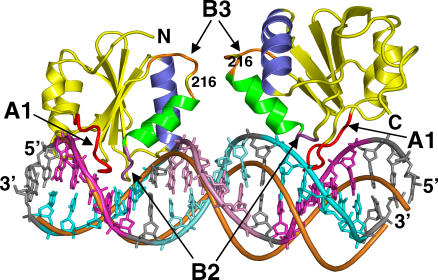
Overall Architecture of T-ag obds Bound to P1 and P3 of the Origin of ReplicationA ribbon diagram shows two T-ag obd monomers bound to the 21-mer DNA. The coloring of the DNA is the same as in Figure 1A. A ribbon diagram of an idealized B-form DNA is shown in orange superimposed on one binding site. The T-ag obd is colored as follows: red (A1 loop, amino acids 147–155), purple (B2 loop, amino acids 202–204), green (helix C), blue (helix B), orange (B3 loop amino acids 213–218), and yellow (Cys216 and the rest of the molecule). This orientation shows two T-ag obds arranged in a head-to-head fashion while engaged with DNA binding sites P3 and P1. This view shows A1 and B2 of each T-ag obd in the major groove of the DNA. All figures of molecules were generated with the molecular graphics program PyMOL [60].